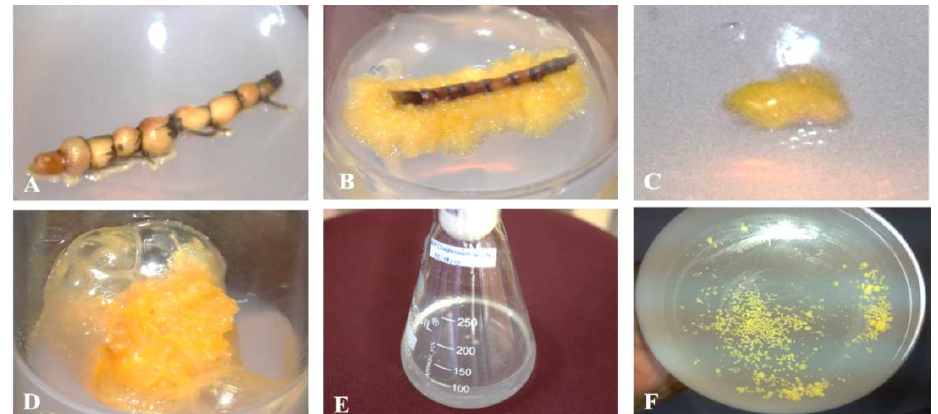
Figure 1. Callus induction and establishment of cellular suspension of H. Pinifolia . ( A ) — Explant; ( B ) — Callus induced from Explant; ( C ) — Callus subculture on 3rd day; ( D ) — Callus subculture on ( B )—Callus induced from Explant; ( C )—Callus subculture on 3rd day; ( D )—Callus subculture on 21st 21st day; ( E ) — Cell suspension culture as larger clump; ( F ) — Suspension cultured cells at granular day; ( E )—Cell suspension culture as larger clump; ( F )—Suspension cultured cells at granular stage.